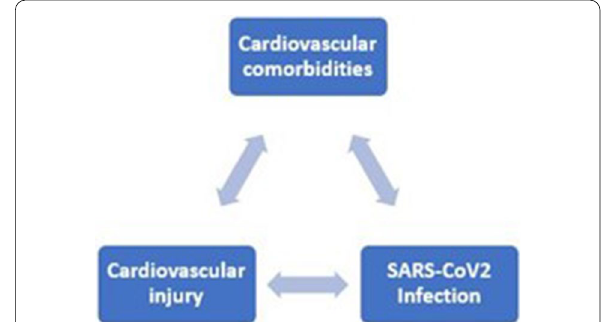
Fig. 1 Mutual relationship between cardiovascular system and COVID-19. Cardiovascular comorbidities are linked to risk and mortality of COVID-19. At the meantime, COVID-19 is associated with cardiovascular injury and